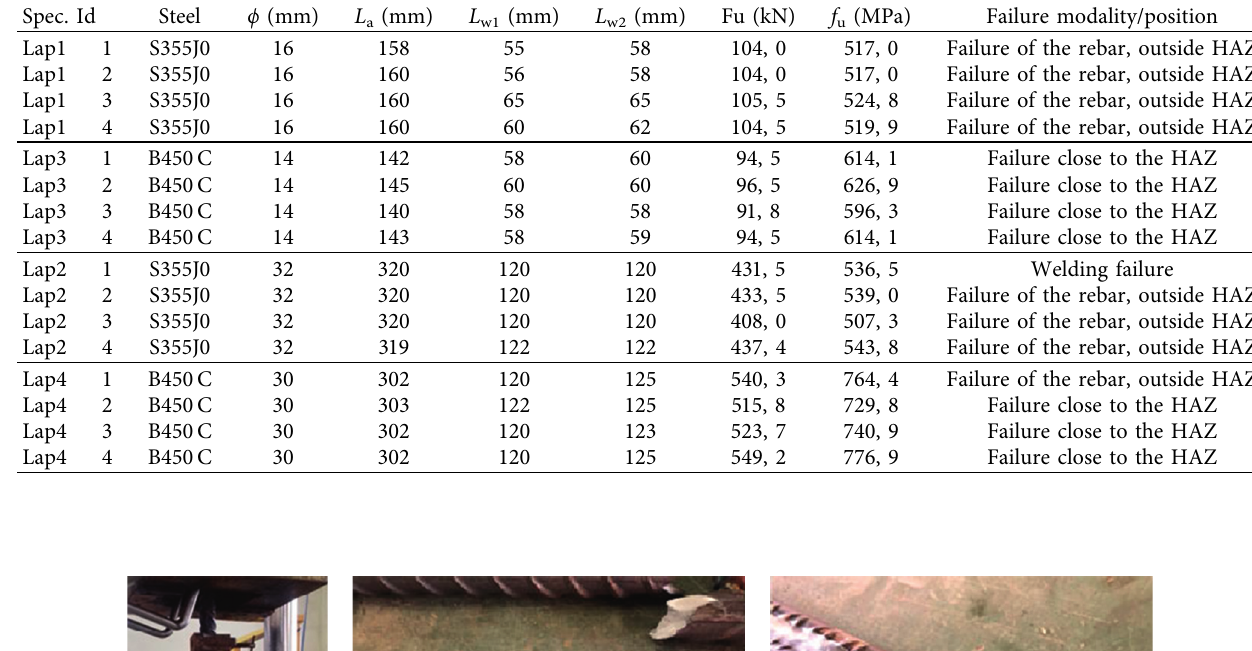
Table 3: Summary of tests’ results on Lap joints.